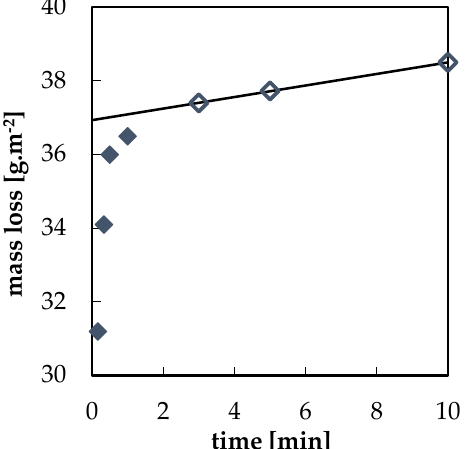
Figure 4. Interval cleaning of specimen with acetate corrosion products in 1% HCl water solution; (cid:169) dissolution of corrosion products; ♦ dissolution of metallic lead.